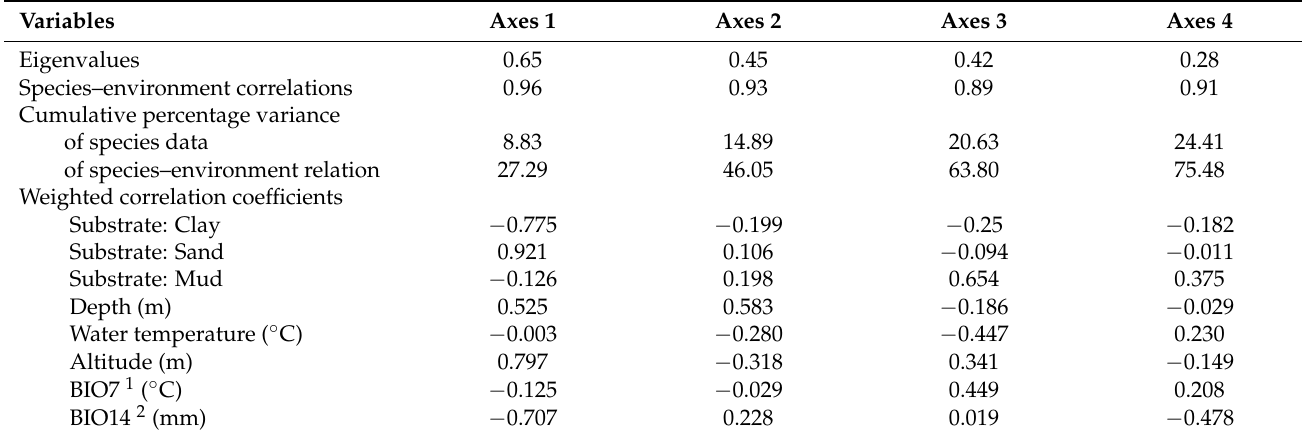
Table 1. Results of canonical correspondence analysis of charophyte presence in relation to environ- mental variables.